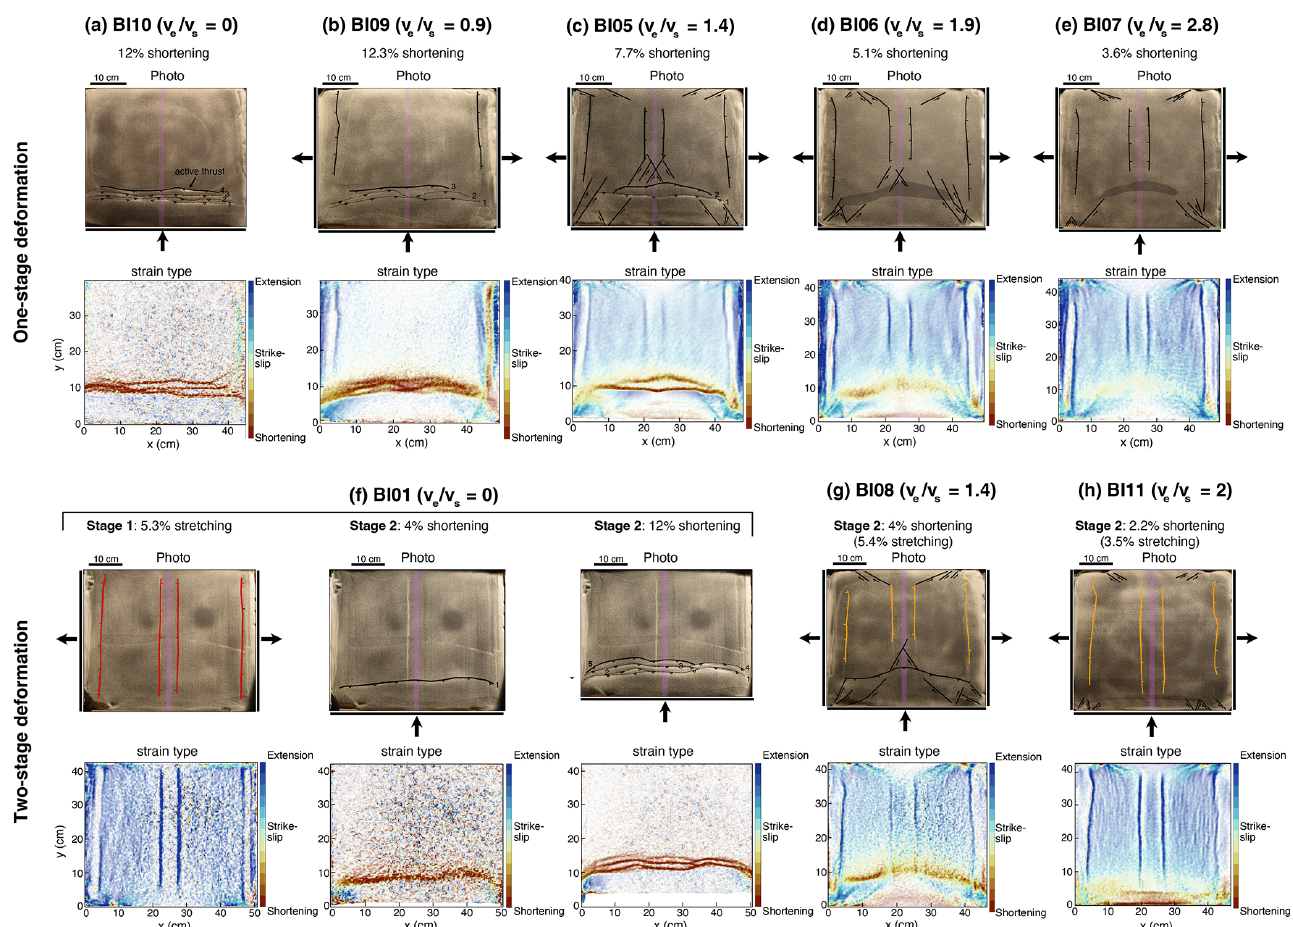
Figure 4. Interpreted pictures and strain type for models with a brittle crust after 12% of along- y shortening for (a) model BI10 and after 10% of along- x stretching for models (b) BI09, (c) BI05, (d) BI06, and (e) BI07 and for models with a brittle crust and two-stage deformation: (f) model BI01, (g) model BI08, and (h) model BI11. Strain type maps show shortening (red), strike-slip (green), and stretching (blue), with intermediate, oblique deformation at intermediate colors. For the two-stage models, faults active only at the first stage of deformation are in red, faults forming and active only at the second stage are in black, and faults that formed at the first stage and are reactivated at the second stage are in orange. The initial location of the seed is indicated in purple. The corresponding amount of along- x stretching and/or along- y shortening is indicated at the top. Corresponding maps for principal stretches λ max , λ min are found in Fig.